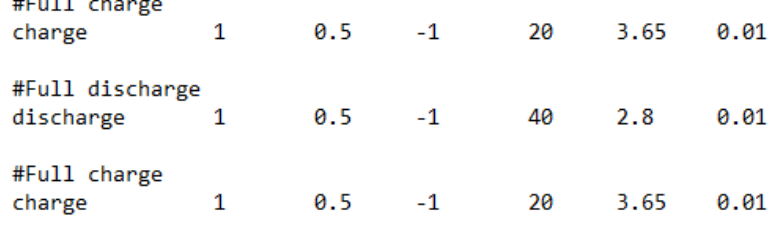
Step-file controlling the CST.